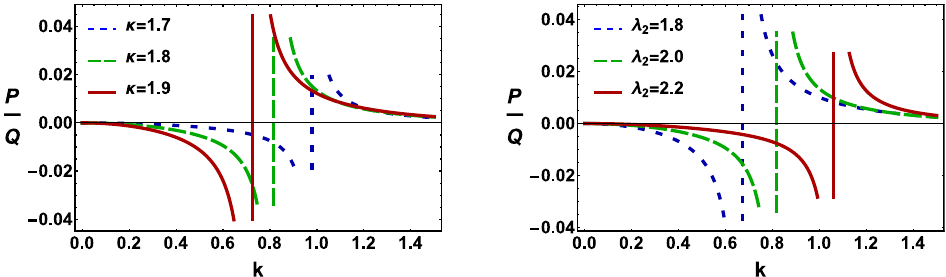
Figure 1. The variation of P / Q with k for different values of κ when λ 2 = 2.0 ( left panel), and the variation of P / Q with k for different values of λ 2 when κ = 1.8 ( right panel). Other plasma parameters are λ 1 = 0.8, λ 3 = 1.5, and λ 4 = 0.4.